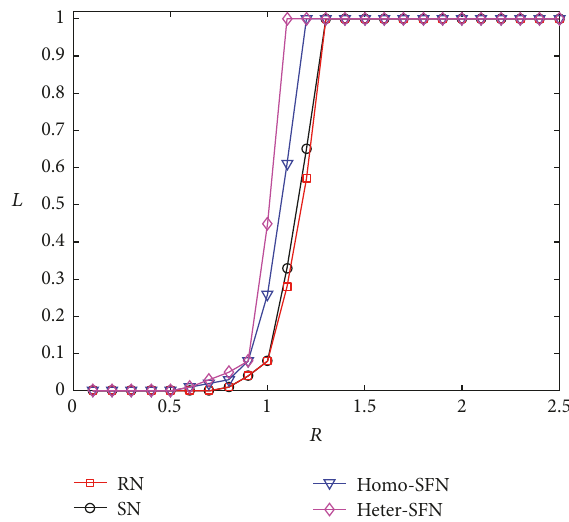
Figure 6: 𝐿 - 𝑅 relation curve under max-degree attack (𝜀 = 0.6) .